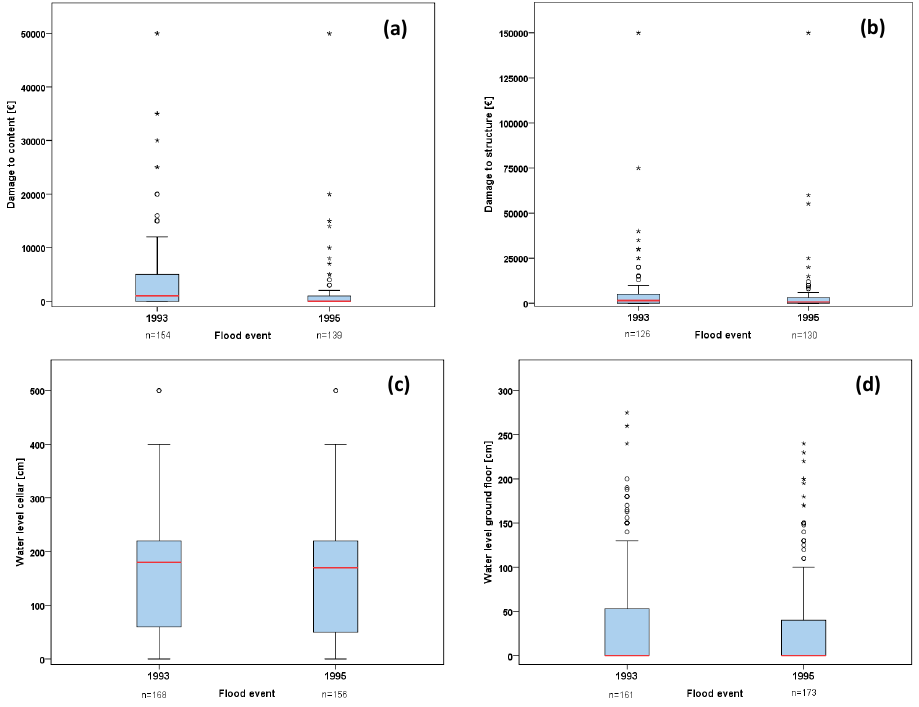
Fig. 2. Box whisker plots of (a) damage to contents, (b) damage to structure, (c) the water level in the cellar, and (d) the water level in the Figure 2: Box-whisker plots of damage to contents (a), damage to structure (b), the water level in the cellar (c), 34 and the water level in the ground floor (d). 35 ground floor. Note that damage to contents, damage to structure, water levels in cellar and ground floor are significantly different (Wilcoxon signed-rank test) at the 1 per cent level. Table 3. Number of total measures implemented by households before the flood in 1993 and the flood in 1995 ( n = 160). Flood mitigation measure 1993 1995 Relocate heating system to avoid contamination